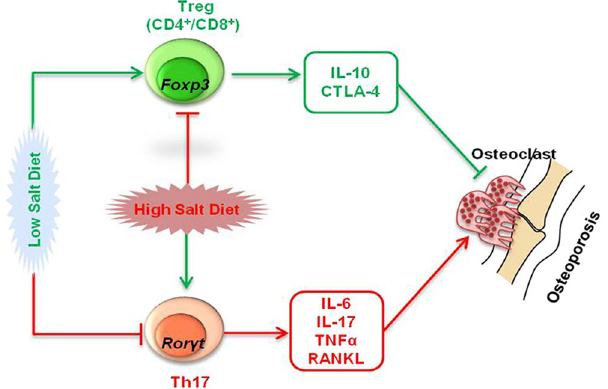
Figure 5. Summary of our results. High dietary salt intake induces bone loss by modulating Treg-Th17 balance in vivo